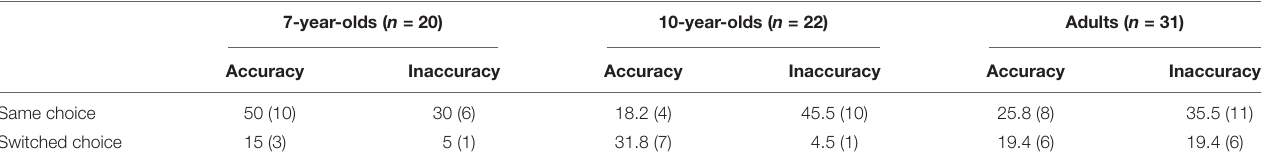
FIGURE 1 | Proportion of responses siding with the teacher and the Internet for each age group during baseline and post-test phases. TABLE 1 | Percentage (and number) of participants who chose the same source or switched the source immediately after intervention as a function of whether the source was accurate or